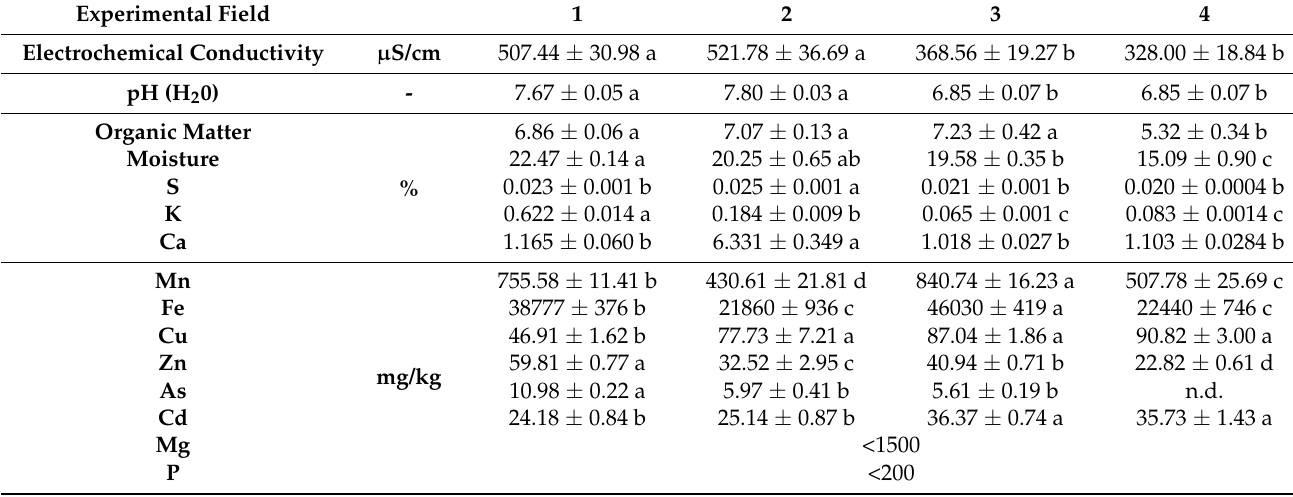
Table 1. Analysis of soils (0–30 cm) of fields 1–4 ( n = 9 for electrochemical conductivity, pH, organic matter and moisture; n = 27 for quantification of chemical elements) of Triticum aestivum L., varieties Roxo and Paiva. Experimental Field Electrochemical